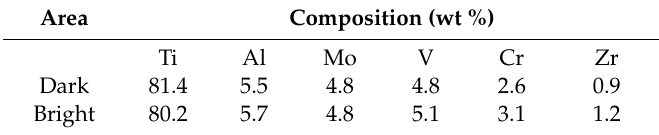
Table 3. Results of EDS analyses for Ti-55531 alloy aged at 500 ◦ C during 1500